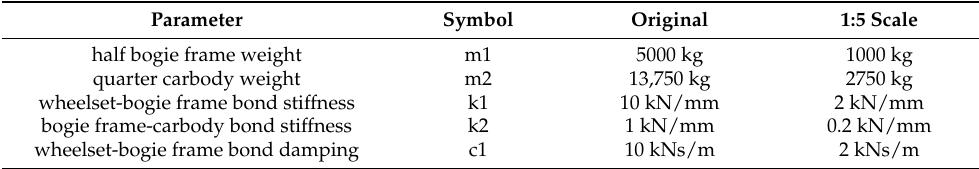
Figure 1. Railway vehicle simplified model schema. Table 1. Model parameters. Table 1. Model parameters.